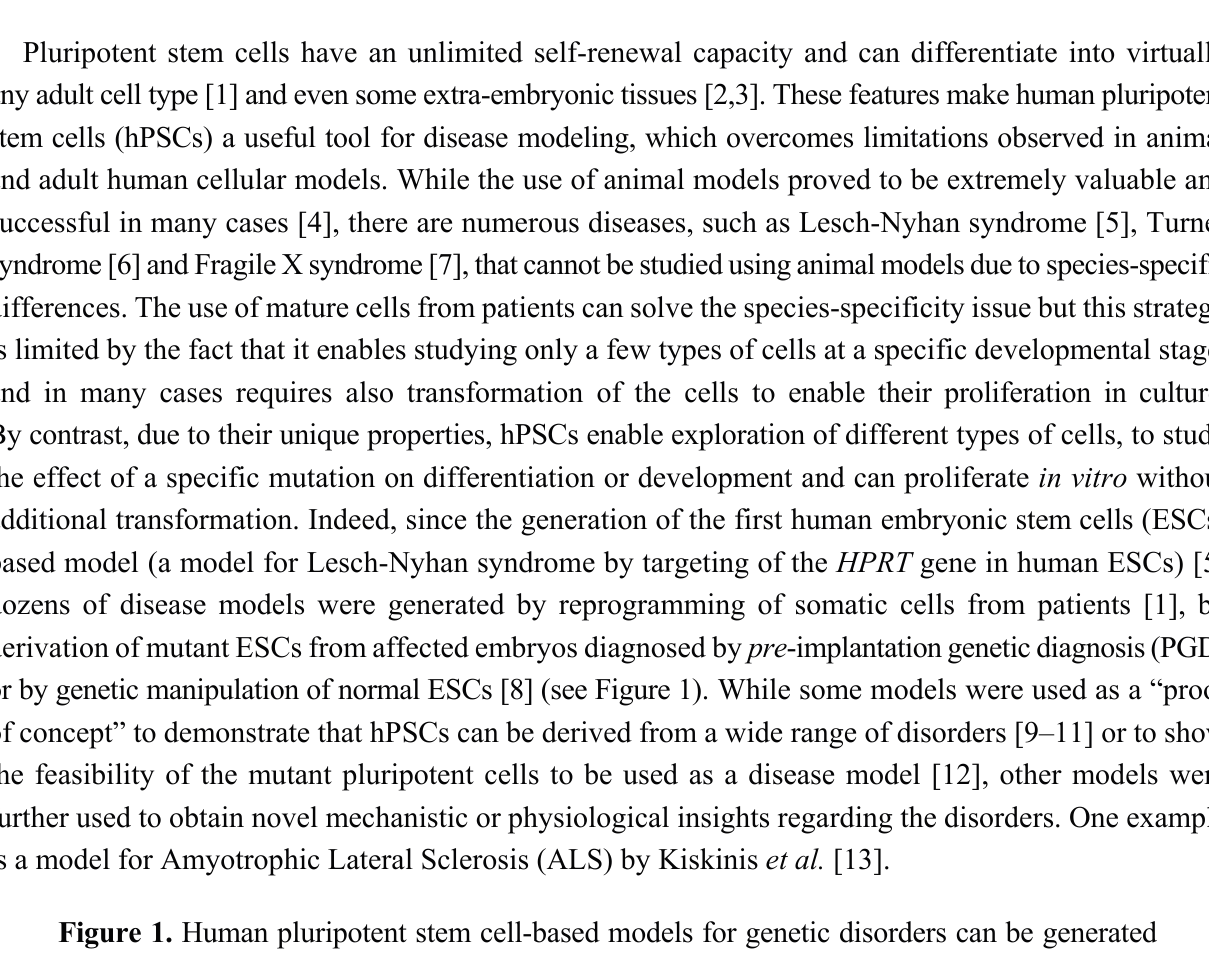
Figure 1. Human pluripotent stem cell-based models for genetic disorders can be generated by different techniques. Mutated human pluripotent stem cells can be derived by genetic manipulation of normal pluripotent stem cells, from affected embryos (identified by PGD), or from adult patients (by reprogramming of somatic cells). Normal